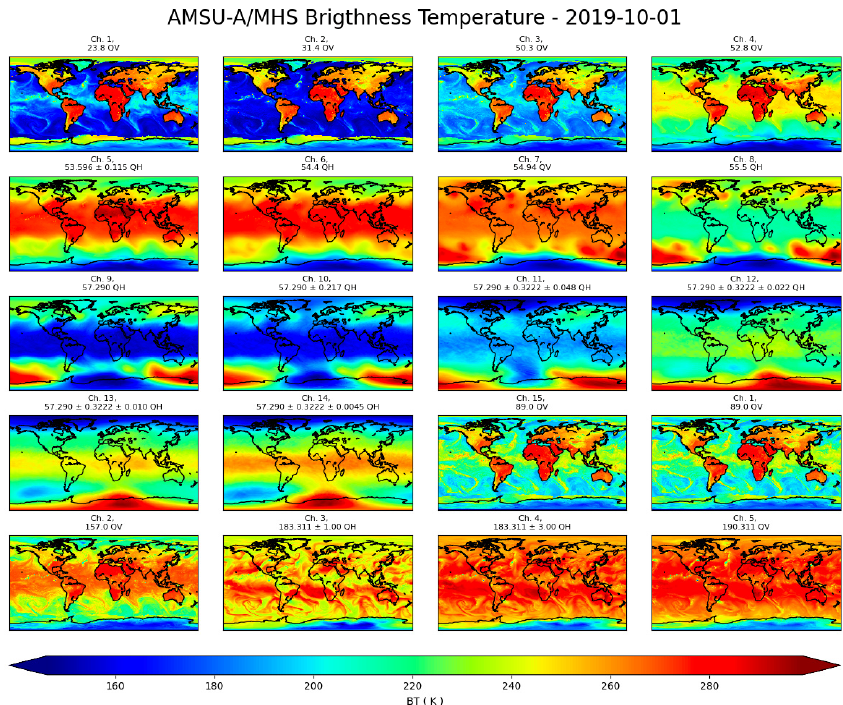
Figure 2. As in Figure 1, but for AMSU-A and MHS (1 October 2019).